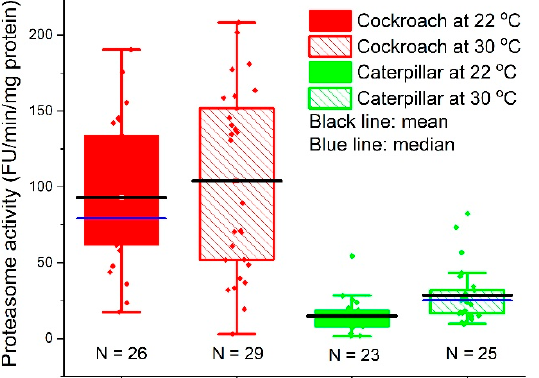
Figure 7. Activities of proteasome in midgut cells from cockroach nymphs and painted lady caterpillars that were reared at 22 and 30 °C. The assays were performed at 25 °C.